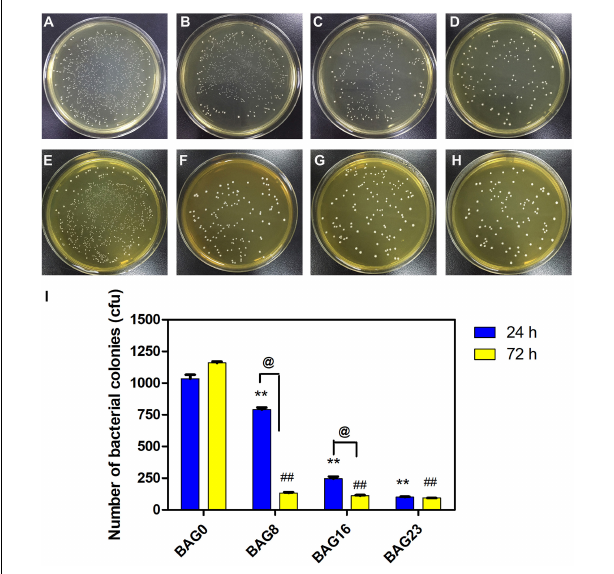
FIGURE 6 | The antibacterial effect of the extracts of modified composite resin with different mass fractions of BAG particles. (A–H) Representative gross images of S. mutans seeded on the BHI agar plate after exposure to the 24-h extracts of (A) BAG0 group, (B) BAG8 group, (C) BAG16 group, and (D) BAG23 group, and the 72-h extracts of (E) BAG0 group, (F) BAG8 group, (G) BAG16 group, and (H) BAG23 group. (I) Bar graph shows quantification and statistical data of colony-forming units (CFUs) of bacterial colonies after different treatments. Data are shown as mean ± SEM, n = 3. BAG0 group as the control. * p < 0.05, ** p < 0.01 vs. the 24 h extracts of BAG0 group, # p < 0.05, ## p < 0.01 vs. the 72 h extracts of BAG0 group, @ p < 0.05 significant difference as compared groups. BAG0 indicates composite resin without BAG; BAG8 indicates composite resin with 8 wt% BAG; BAG16 indicates composite resin with 16 wt% BAG; BAG23 indicates composite resin with 23 wt% BAG.